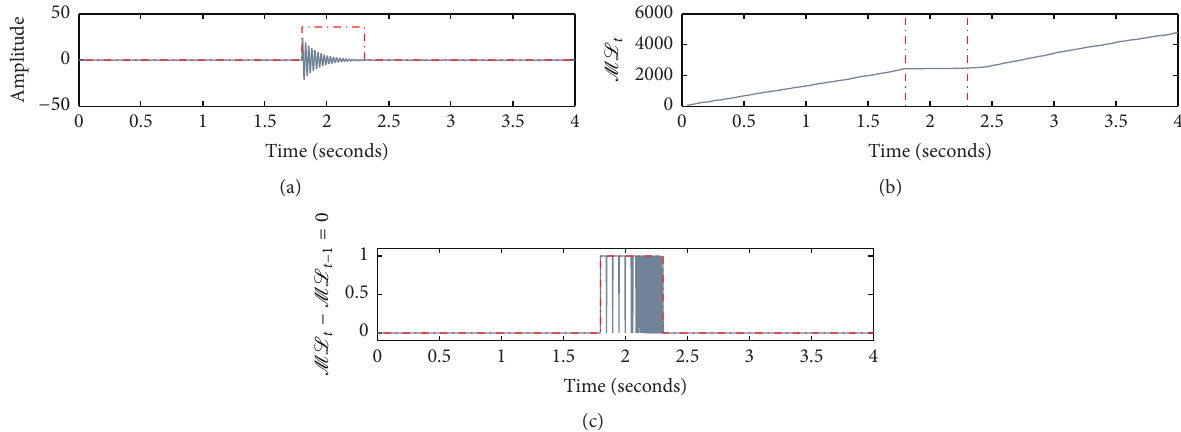
Figure 1: The application of the proposed method to the simulated data record using the signal described in Section 3. (a) Detection of the seismic signal in the recorded dataset. (b) Sequence of the test statistics ML 𝑡 . (c) The application of the smoothing procedure used for segmentation purposes based on ML 𝑡 statistics. The grey curves depict the nonsmoothed differences between consecutive values of the test statistics, whereas the red curve is used for marking the final